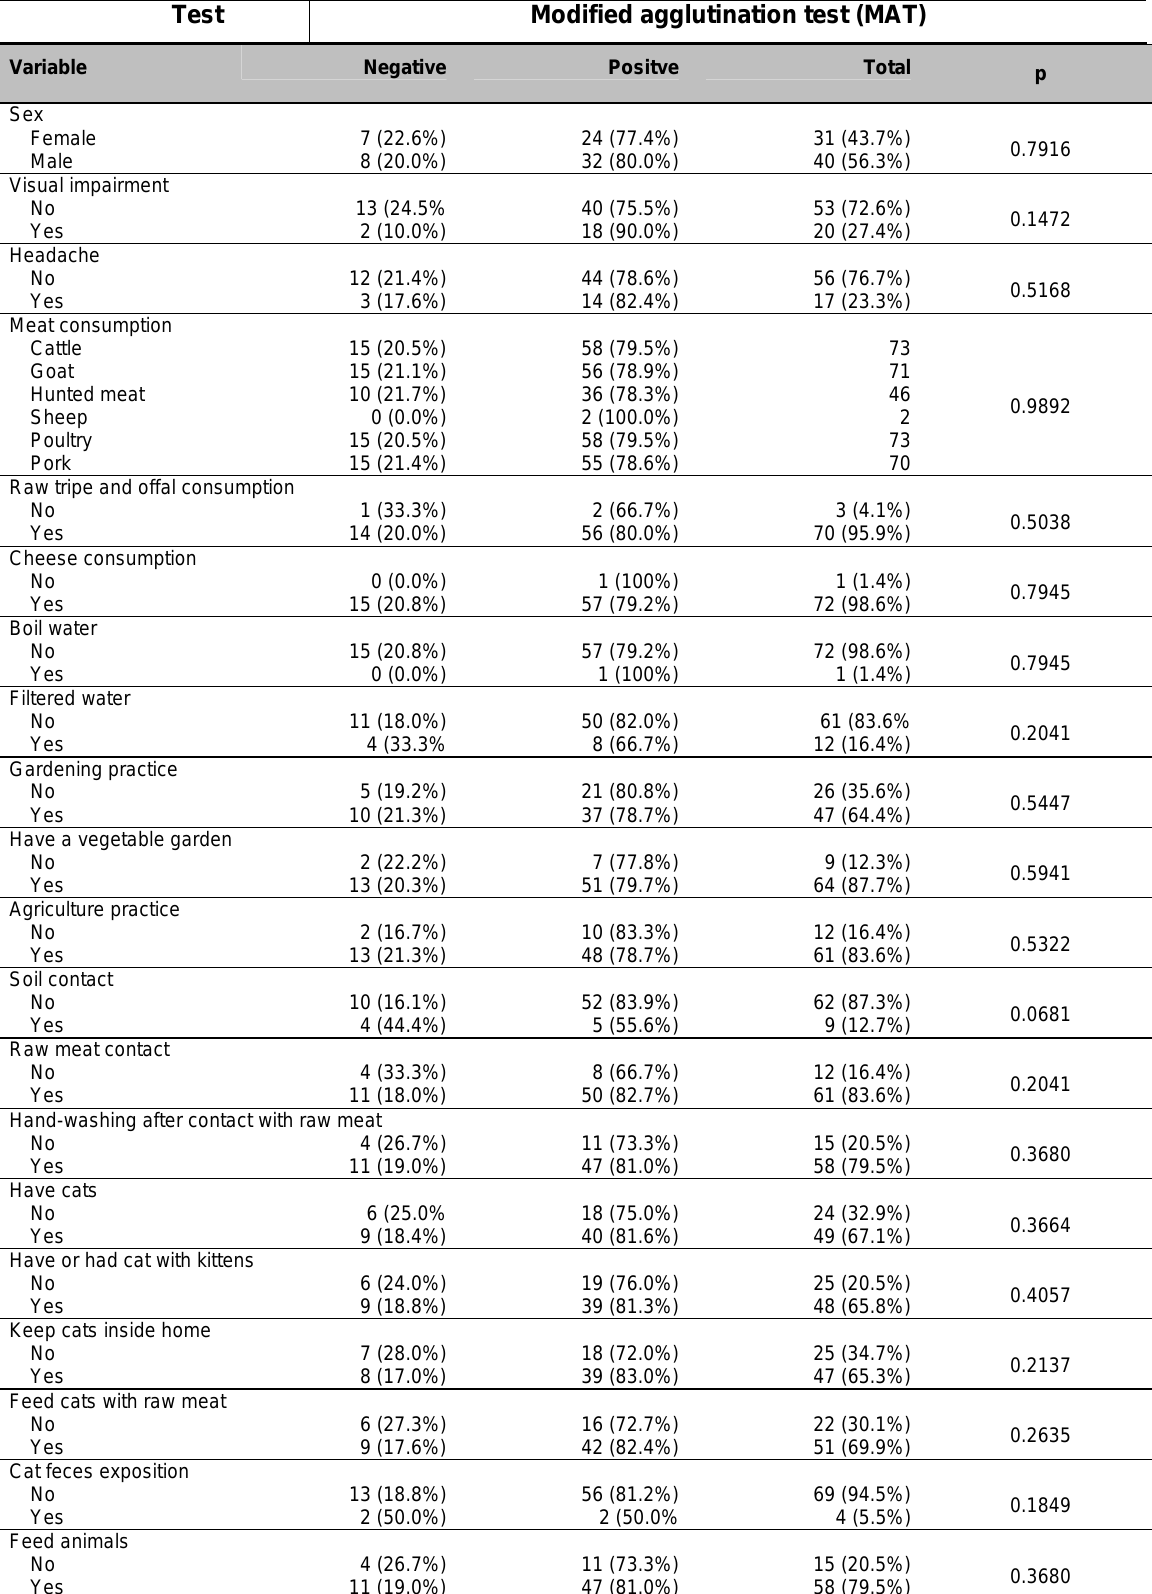
Table 1. Analysis of the association among studied variables and the presence of anti- Toxoplasma gondii antibodies in humans from a rural population, in Eldorado, Mato Grosso do Sul State, Brazil, 2007 Test Modified agglutination test